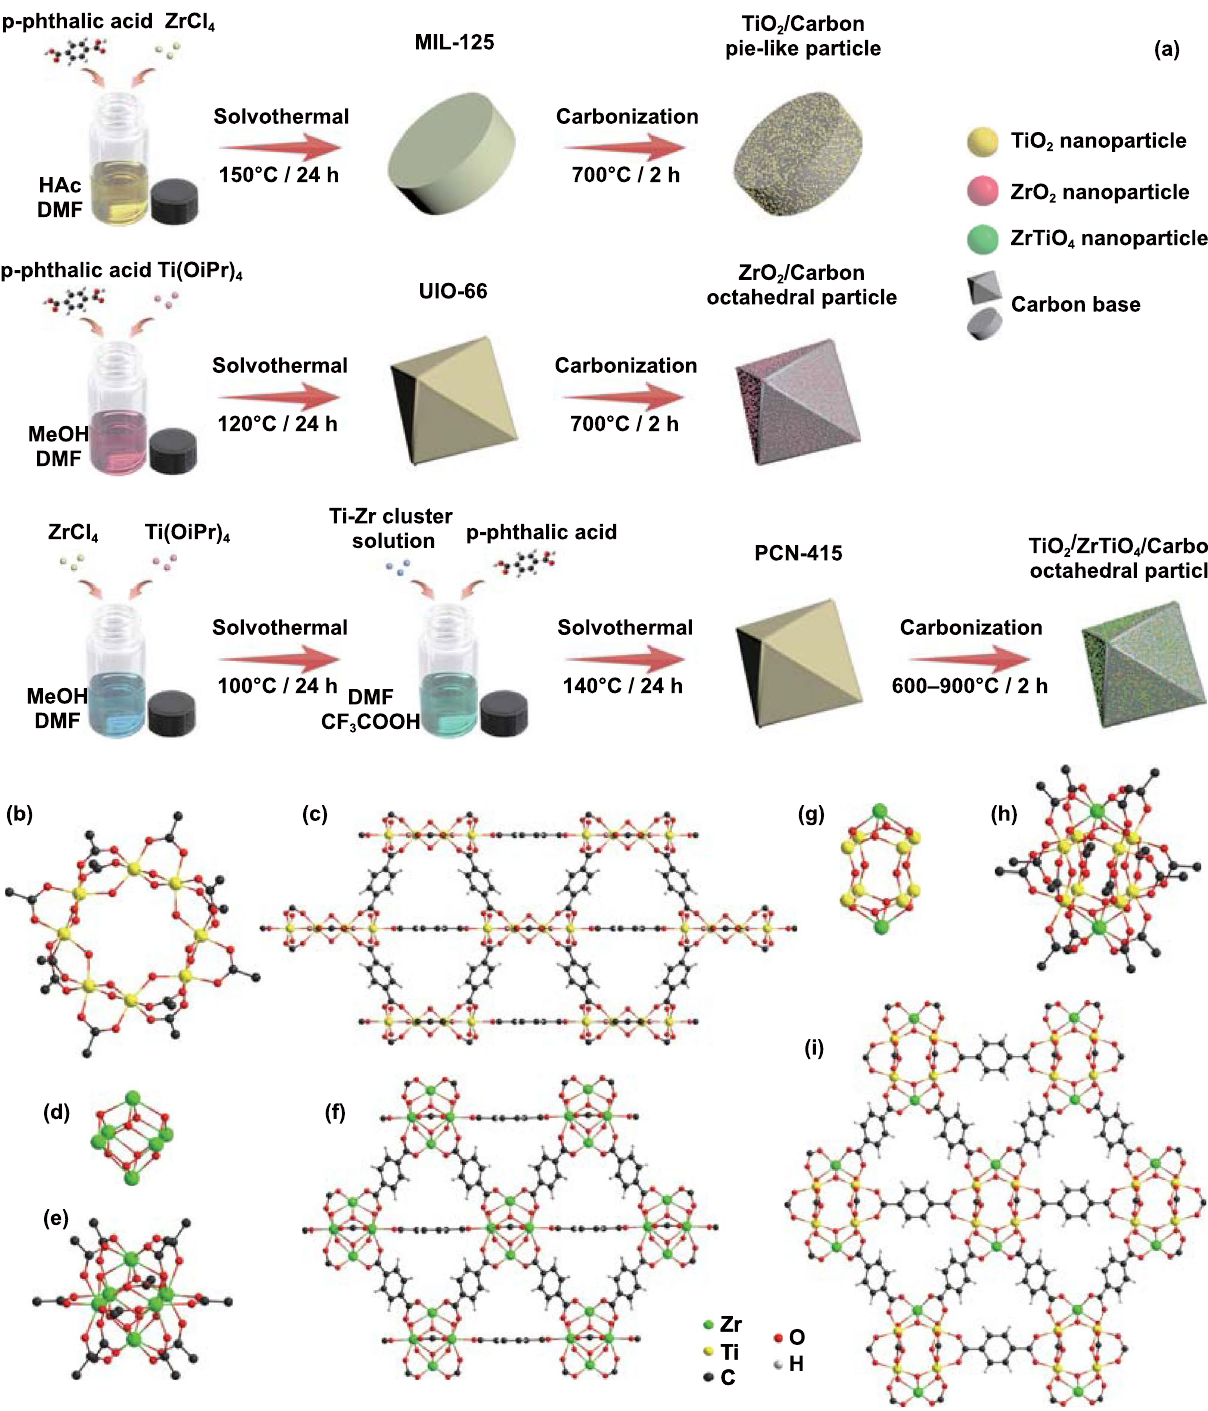
Fig. 1 Schematic illustrations for a synthesis of MIL-125, UIO-66 and PCN-125 derivatives, b Ti-oxo cluster in MIL-125. c Crystal structure of MIL-125, d Zr 6 core in UIO-66, e Zr-oxo cluster in UIO-66. f Crystal structure of UIO-66, g Ti 8 Zr 2 core in PCN-415, h TiZr-oxo cluster in PCN-415. i Crystal structure of